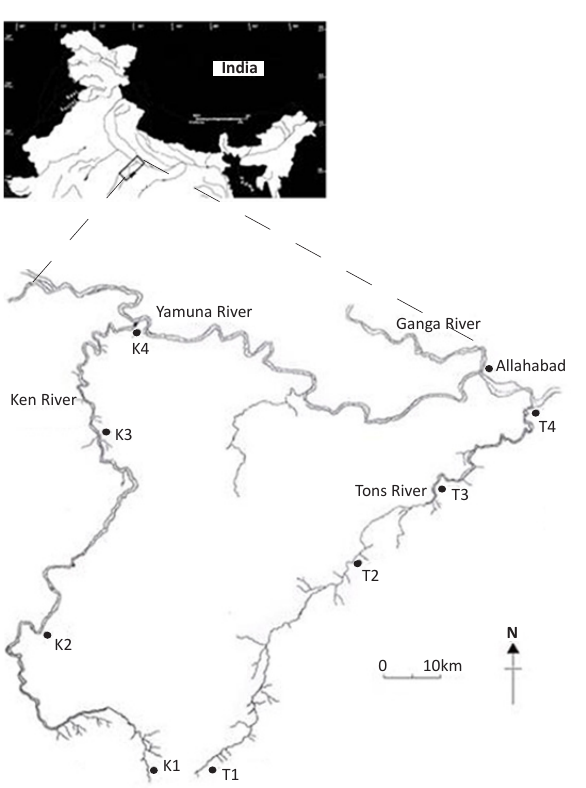
Figure 1. Location of the Ken and Tons rivers in India and sampling stations (K1 to K4 and T1 to T4) selected for the